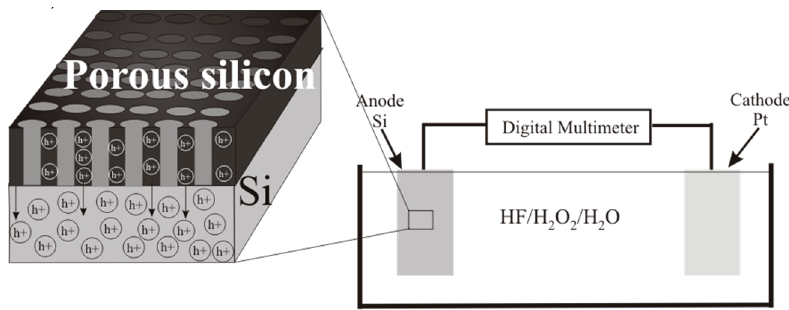
Figure 4. Schematic of the galvanic cell.